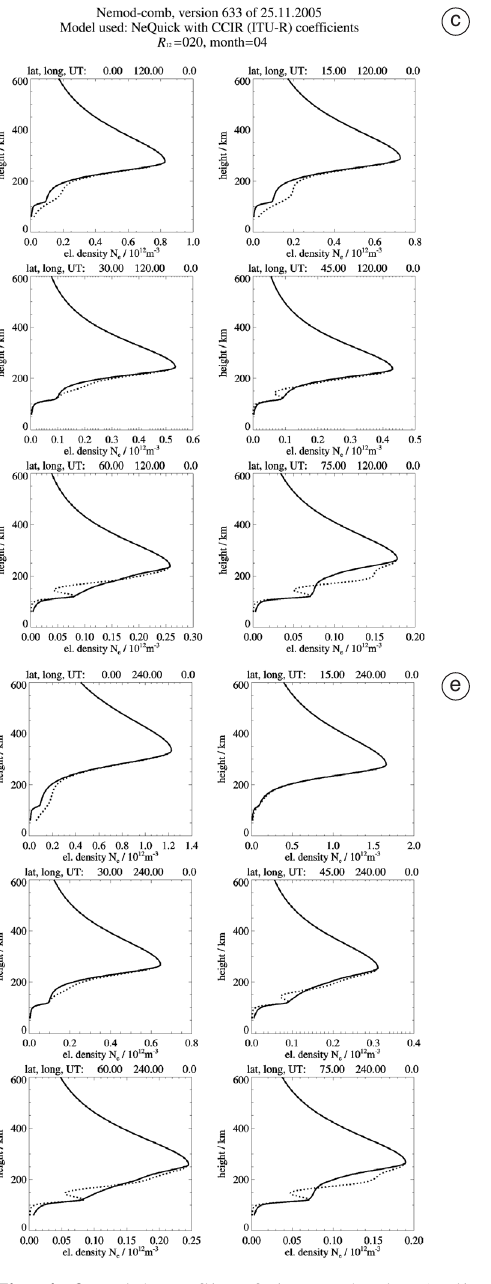
Fig. 4c-f. Height profiles of electron density: April; R 12 = 20; 0 h UT; geografic longitude 120°E (c), 180°E (d), 240°E (e), 300°E (f); 8 h LT (c), 12 h LT (d), 16 h LT (e), 20 h LT (f); geografic latitudes 0°N ( top left ) to 75°N ( bottom right ); latitude spacing 15°. Solid curves: revised NeQuick, dotted curves: NeQuick, old